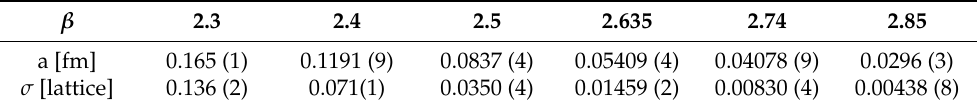
Table 1. The values of the lattice spacing in fm and the string tension corresponding to the respective value of β are taken from the Refs. [12–16], setting the physical string tension to ( 440 MeV ) 2 .